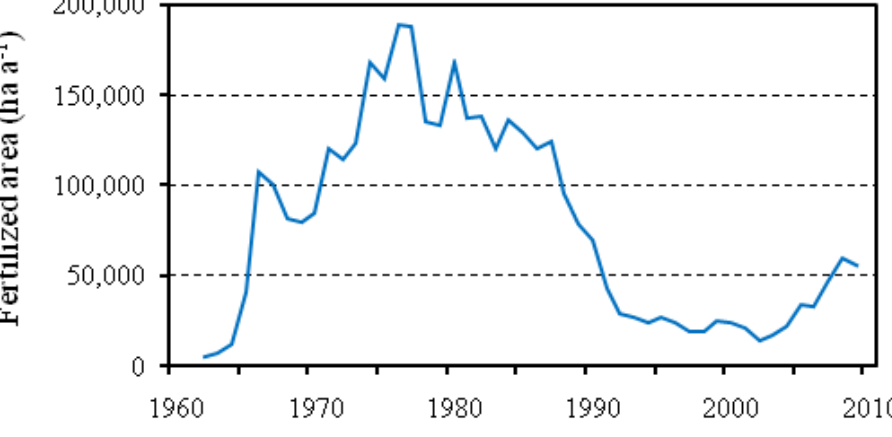
Figure 1. Forest fertilization in Sweden, 1962–2009. Large-scale fertilization with nitrogen on mineral soils  1-6 